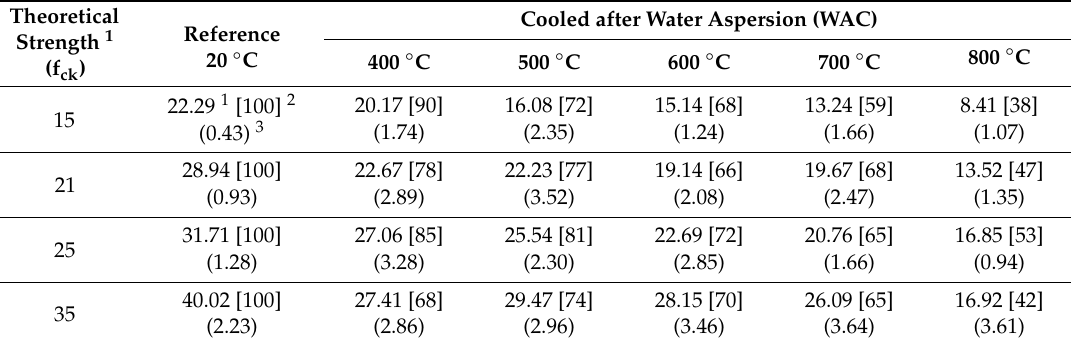
Table 3. Results of the compressive strength for water aspersion cooling.